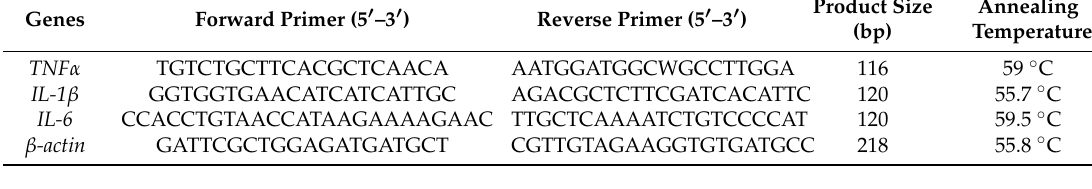
Table 3. Primers used in real-time polymerase chain reaction (RT-PCR) analysis.